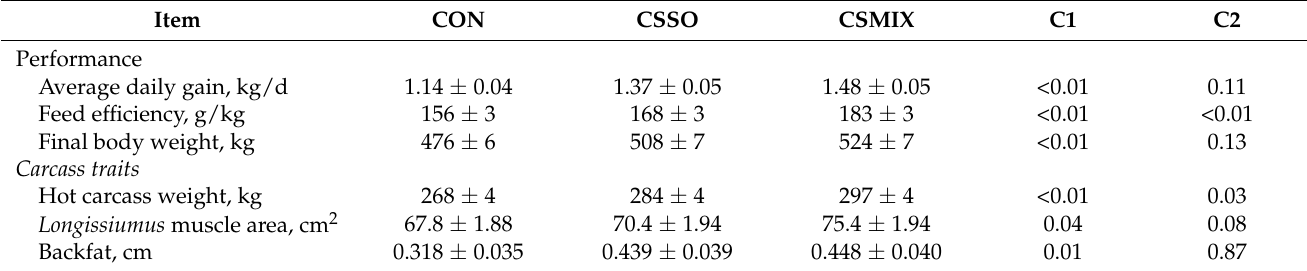
Table 7. Performance and carcass traits of feedlot bulls supplemented or not (CON; n = 16) with Ca soaps of soybean oil (CSSO; n = 16) or a mixture of palm, soybean, and cottonseed oils (CSMIX; n = 15) until slaughter. Values reported are least square means ± standard error. Adapted from Nascimento et al. [70] 1